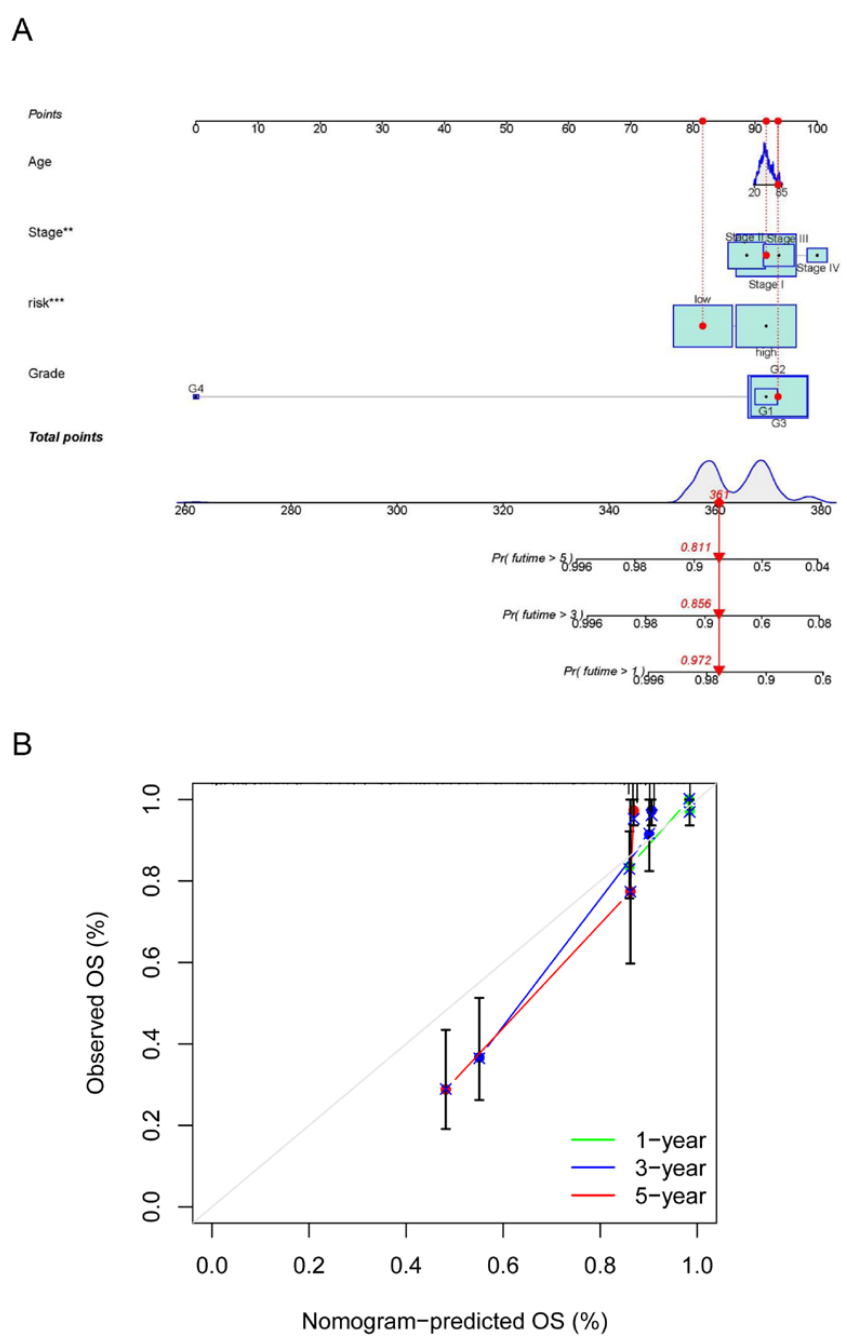
Figure 7. Establishment and calibration of a predictive nomogram. ( A ) The nomogram for predicting OS in CC patients; ( B ) calibration plots of the constructed nomogram in all samples. ** p < 0.01, *** p < 0.001.